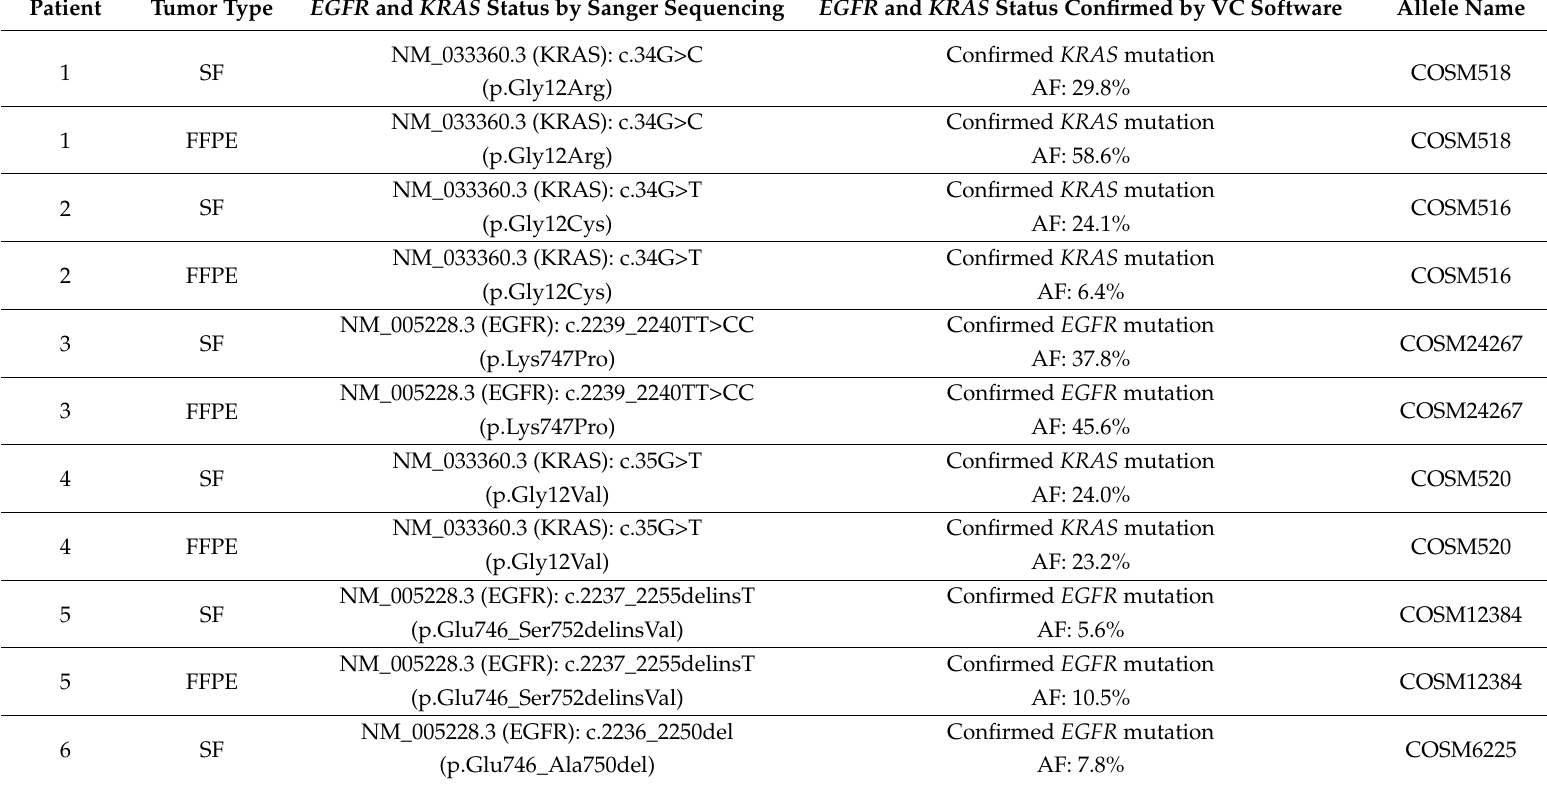
Table 1. EGFR and KRAS mutational status comparison between Sanger Sequencing and NGS (Next-Generation Sequencing) Variant Caller software. This table reports the EGFR or KRAS mutational status, previously defined by Sanger Sequencing from the 12 patients compared to the Variant Caller NGS results. The EGFR or KRAS mutation nomenclature is based on the convention recommended by the Human Genome Variation Society